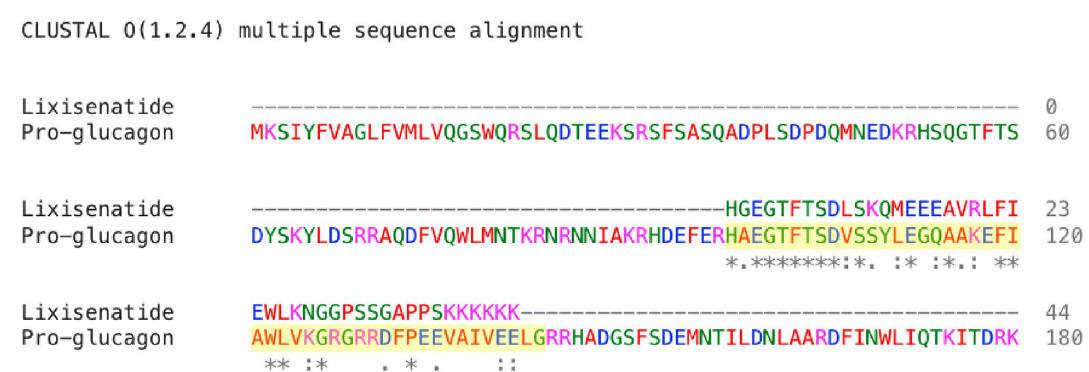
Figure 6. Alignment between lixisenatide and pro-glucagon. Results of the alignment between lixisenatide and pro-glucagon generated with Clustal Omega 31 . The highlighted region corresponds to the endogenously expressed GLP1